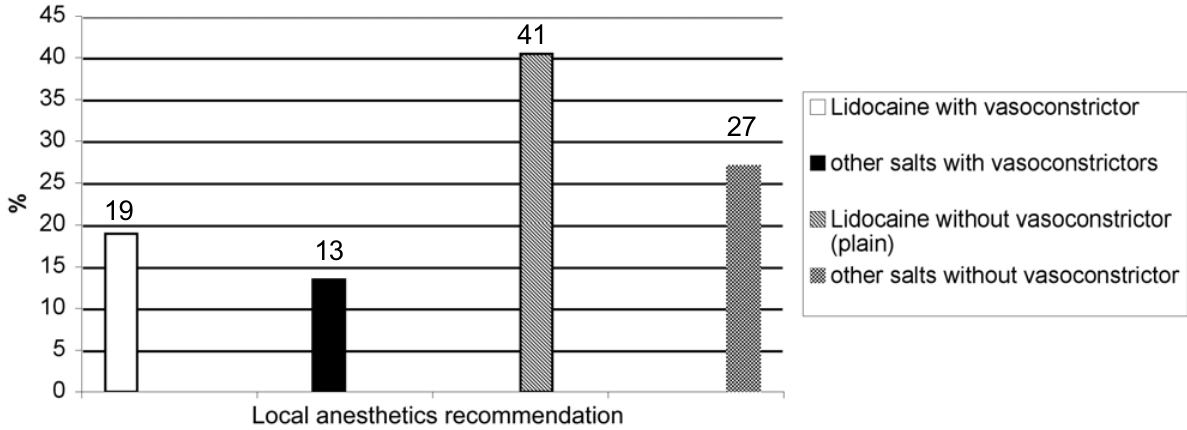
FIGURE 4- Recommendation of local anesthetics by dentists